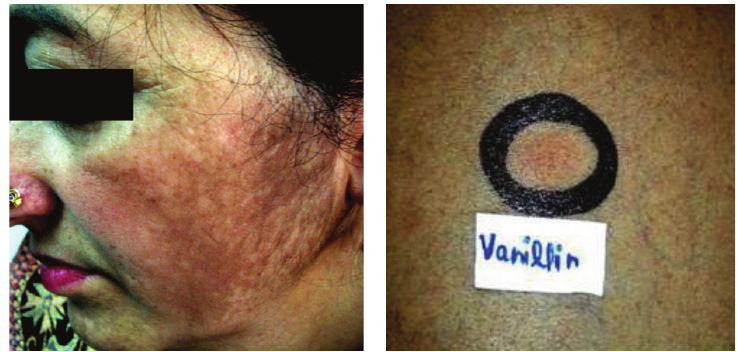
Figure 6: Positive patch test from vanillin in a patient with diffuse-to-reticulated mandibular pattern of